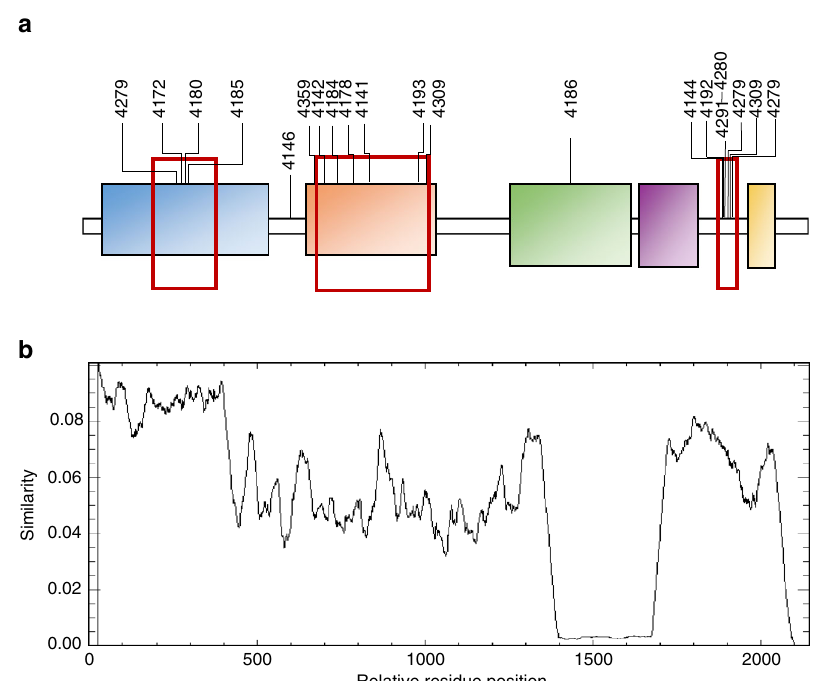
Fig. 4 a Analysis of junctions at contraction regions found following analysis of the rapamycin PKS genes present in strains producing high titres of ring contracted rapalogs. Potential recombination hotspots are shown with red boxes, strain numbers are shown above the junctions. Domain boundaries corresponding to the Ketosynthase (KS), Acyltransferase (AT), Enoyl Reductase (ER), Ketoreductase (KR) and Acylcarrier Protein (ACP) are highlighted. b A similarity graph generated using Plotcon (http://emboss.bioinformatics.nl/cgi-bin/emboss/plotcon, generated via comparison of all of the modules in the native rapamycin